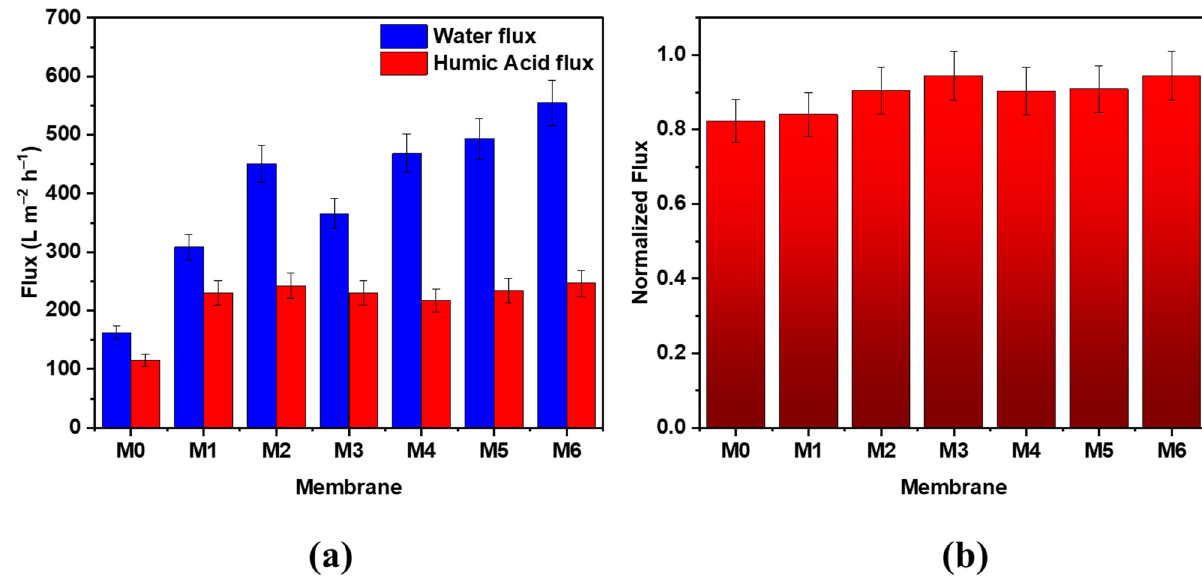
Figure 8. ( a ) Permeate fluxes during filtration of pure water and HA solutions with bare PES, PES/MWCNTs, and PES/GO hybrid membranes, and ( b ) corresponding normalized flux for different PES hybrid